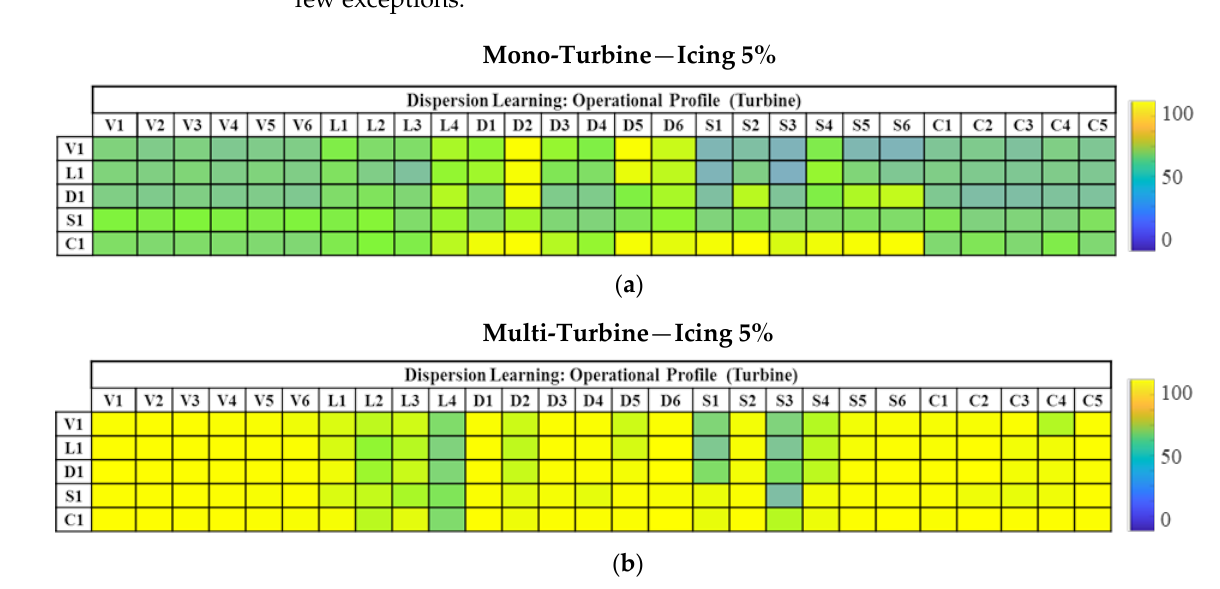
Figure 11. Performance evaluation matrix presented in Section 4.2 and Table 1 filled with 𝑃𝐷 10 cal- culated using: ( a ) Method 1- ‘mono’ for Icing of 5% (0 – 100 on Blue-Green-Yellow Scale) ( b ) Method lated using: ( a ) Method 1- ‘mono’ for Icing of 5% (0–100 on Blue-Green-Yellow Scale) ( b ) Method 1- 1- ‘multi’ for Icing of 5% (0 – 100 on Blue-Green-Yellow Scale). ‘multi’ for Icing of 5% (0–100 on Blue-Green-Yellow